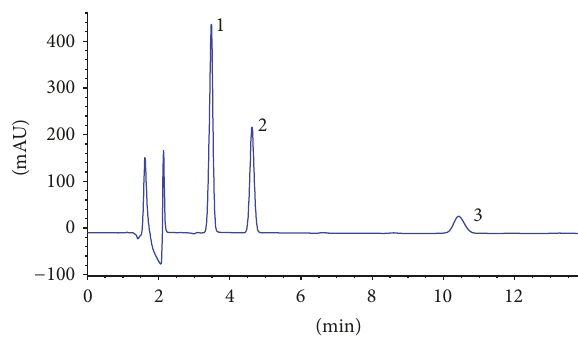
Figure2:HPLCchromatogram:(1)sodiumbenzoate,(2)potassium sorbate, and (3)